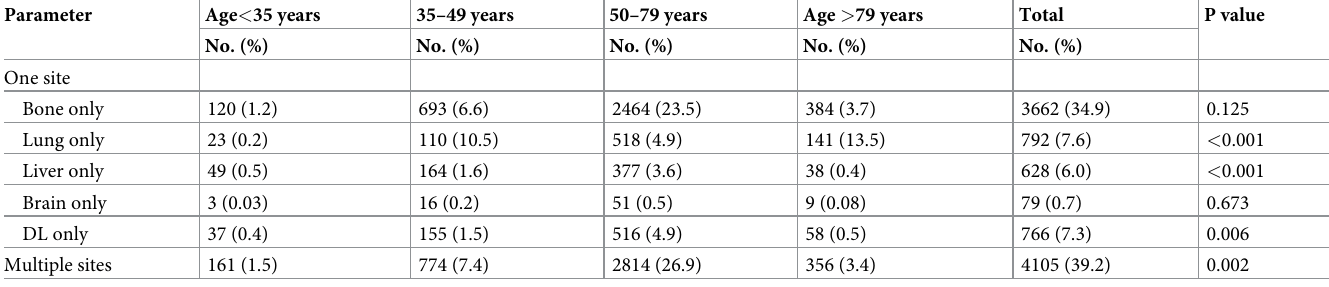
Table 2. Comparison of organ metastasis patterns of patients with metastatic breast cancer by age